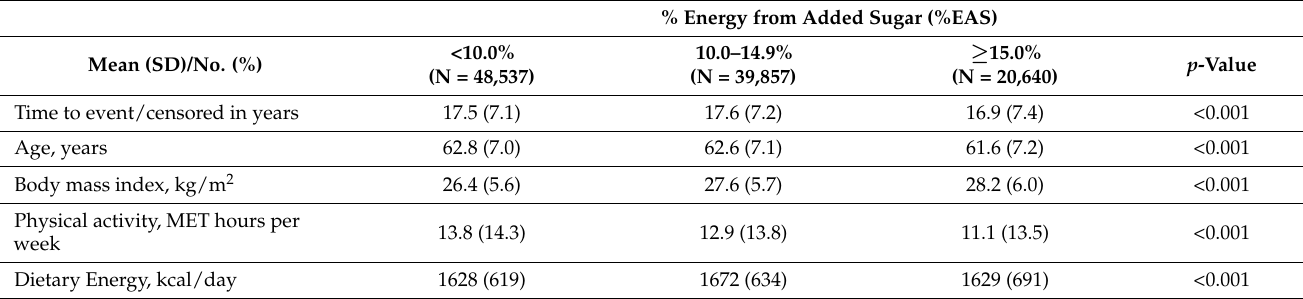
Table 1. Baseline characteristics of 109,034 participants initially free of cardiovascular disease in the Women’s Health Initiative According to percent energy from added